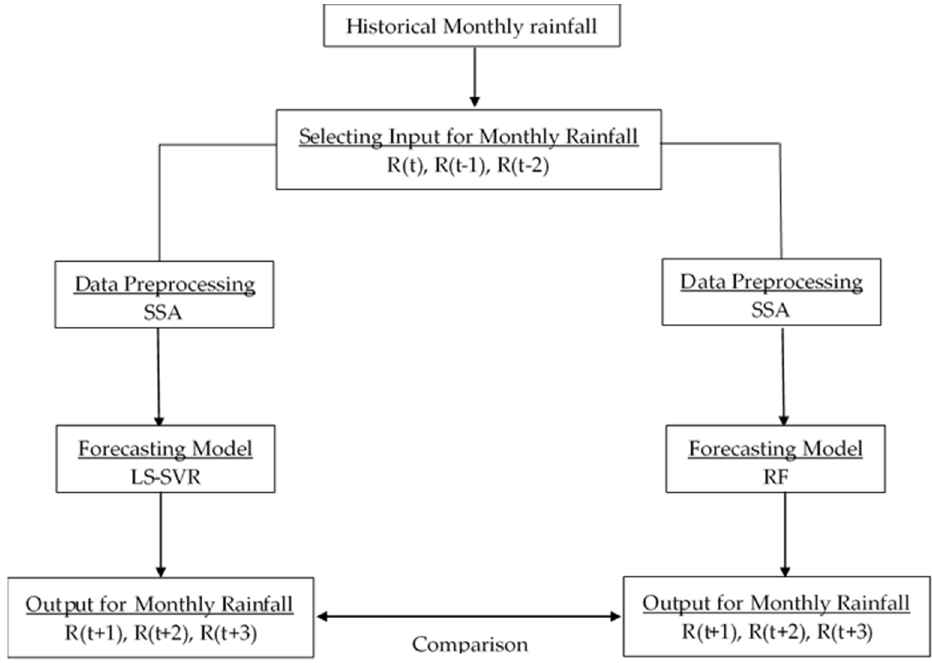
Figure 2. Structure of the hybrid model (i.e., SSA-LSSVR, and SSA–RF).